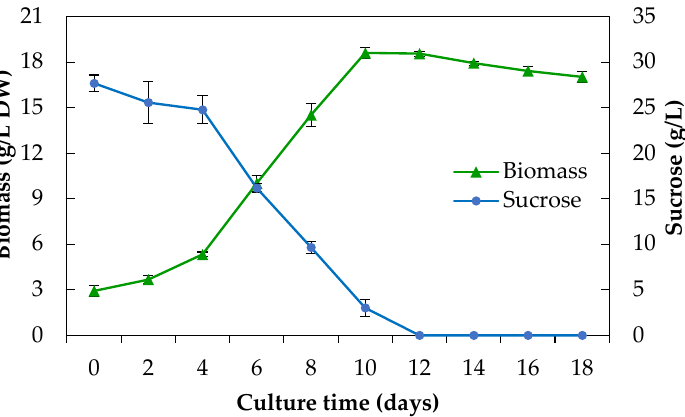
Figure 2. Growth kinetics and consumption of sucrose of a cell suspension culture of Eysenhardtia platycarpa for 18 days of culture. Values represent the mean ± standard deviation of three replicates.